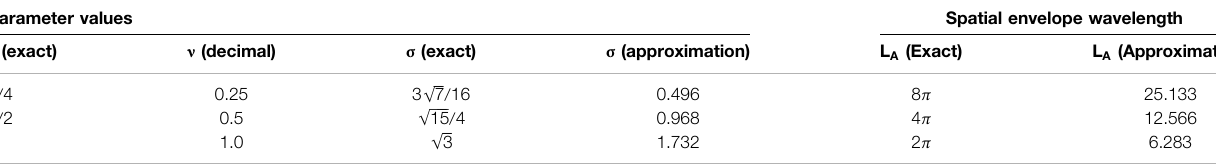
TABLE 2 | Exact values of the spatial envelope wavelength L A and their approximate values for selected parameter values ] corresponding to the Akhmediev soliton. Parameter values Spatial envelope